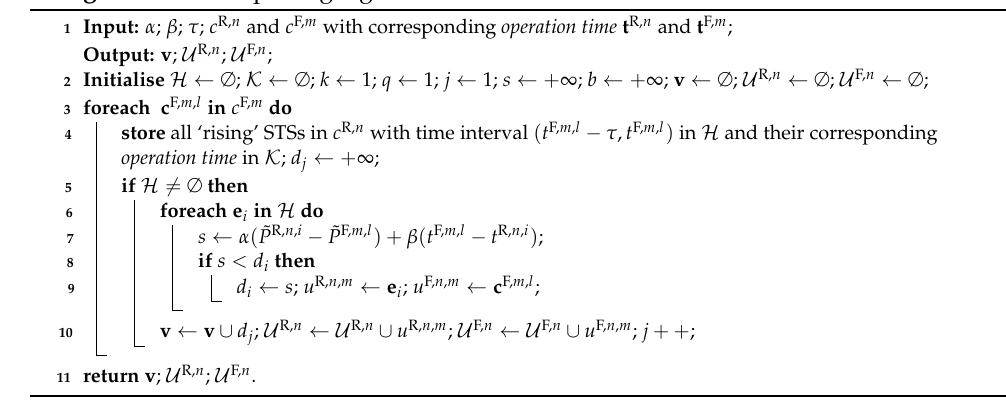
Algorithm 3: STS pairing algorithm